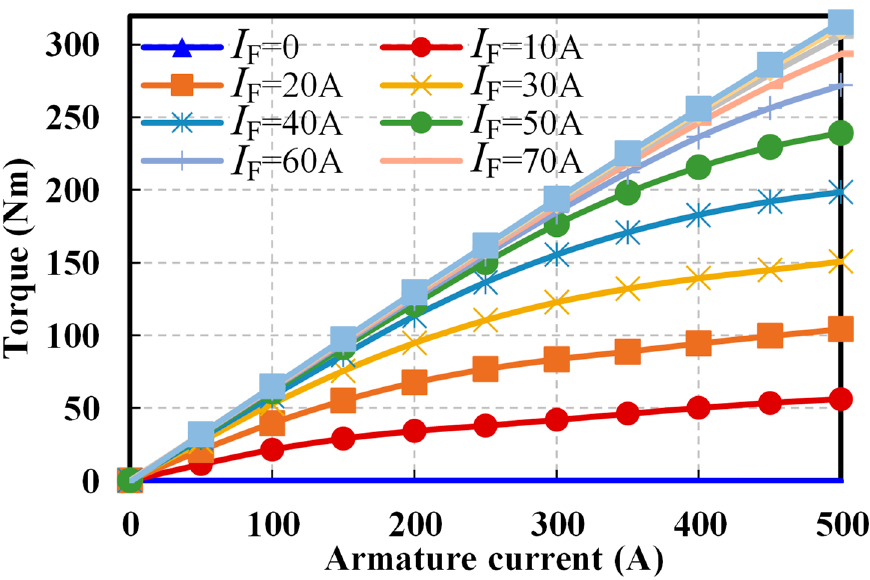
Figure 4. The torque of the WFSM changing with armature current under different exciting currents. Figure 5 depicts the efficiency map of the WFSM. It only considers the electromagnetic loss of the WFSM, and some losses of mechanical aspects are ignored. As shown in Figure 5, the highest efficiency is up to 97% and the largest torque is 160 Nm. Over the wide range of the speed, the efficiency is more than 90%. At the rated speed of 8000 r/min, when the torque is the largest at 160 Nm, the efficiency of the proposed WFSM is still up to 97%. Additionally, the inductive line voltage is 306 V, which is lower than the DC bus voltage.